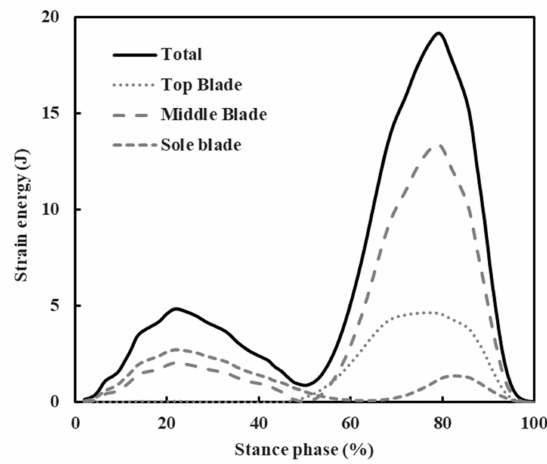
Figure 5. Strain energy of flexible spring blades compared to work at boundaries. Dotted lines show strain energy for individual blades of the prosthetic foot for the load case in the step